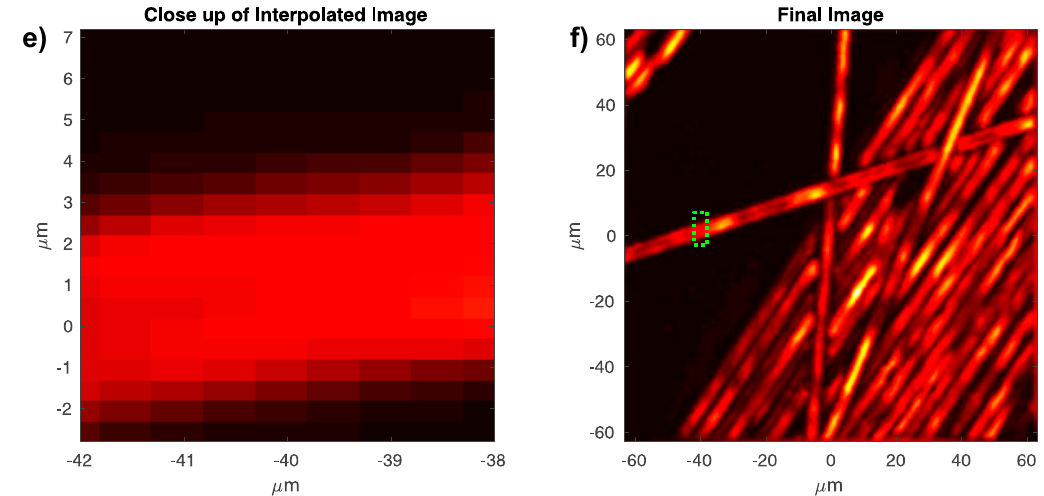
Figure 2. ( a ) PARS time-domain signal with upper and lower envelopes ( b ) raw scatter data ( c ) Delaunay triangulation ( d ) cartesian grid imposed on Delaunay triangulation ( e ) close up of interpolated pixels ( f ) reconstructed image.